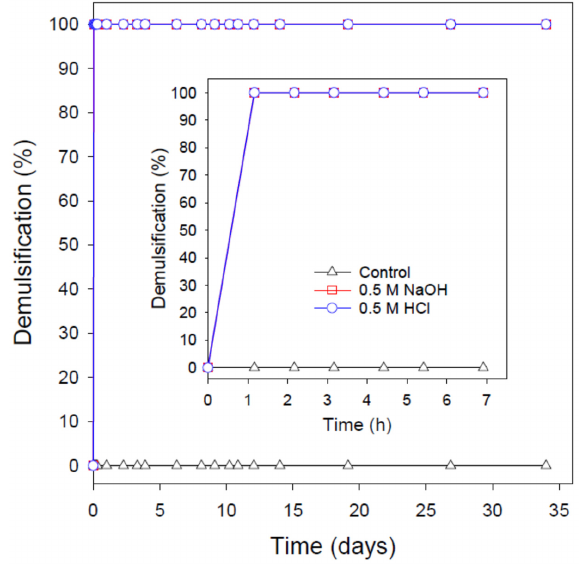
Figure 6. The long-term stability and demulsification process of the crude O/W nanoemulsion stabilized by 0.1 wt% SDBS using the pH-switching mechanism through the addition of 0.5 M HCl or NaOH. The demulsification process was conducted at ambient conditions and in the absence of any physical disturbances. The first 7 h of the demulsification process is shown in the inset.